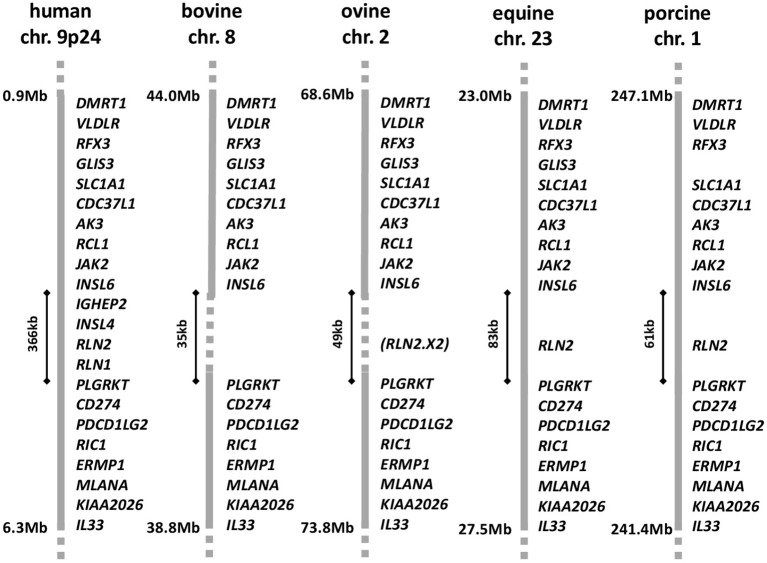
Gene synteny for the corresponding regions of the DMRT1 locus in the relevant chromosomes for human, bovine, ovine, equine, and porcine genomes, based on the latest annotation lists and sequence information in the NCBI database (release Dec 2016). The region between INSL6 and PLGRKT is expanded in the human genome to accommodate the recent local anthropoid gene duplications giving rise to INSL4 and RLN1. The equivalent region in horses and pigs is shorter and accommodates only a single member of the relaxin family, RLN2, representing the primitive mammalian constellation. In sheep and cows this region is reduced again, with a partial or complete deletion of the RLN2 gene, respectively. In sheep, only a remnant corresponding to the A-chain encoding exon 2 of the RLN2 gene is present.